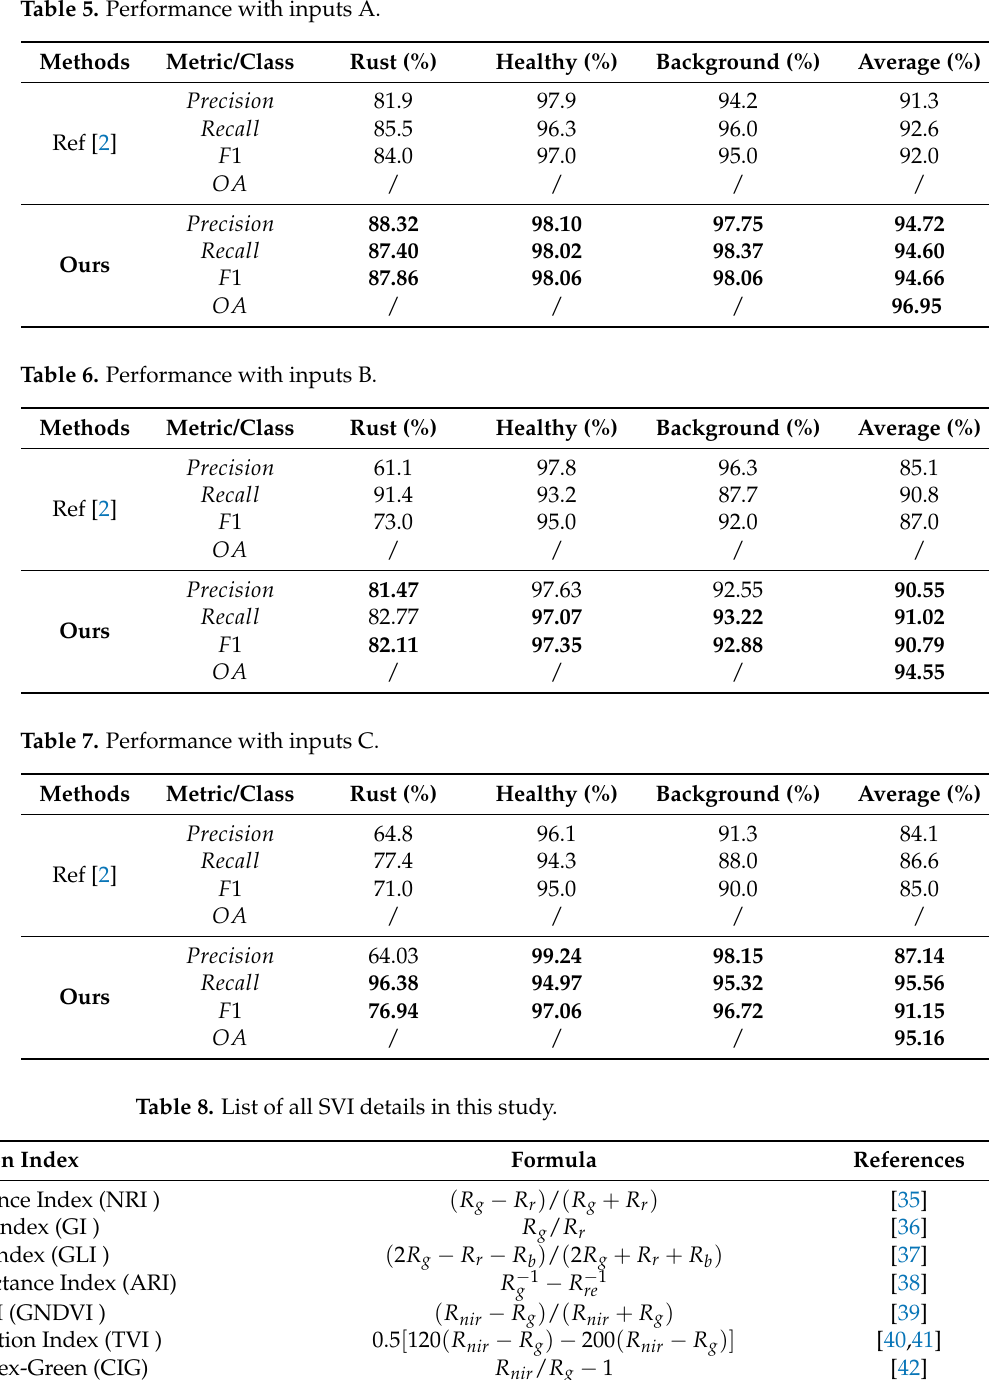
Table 5. Performance with inputs A.